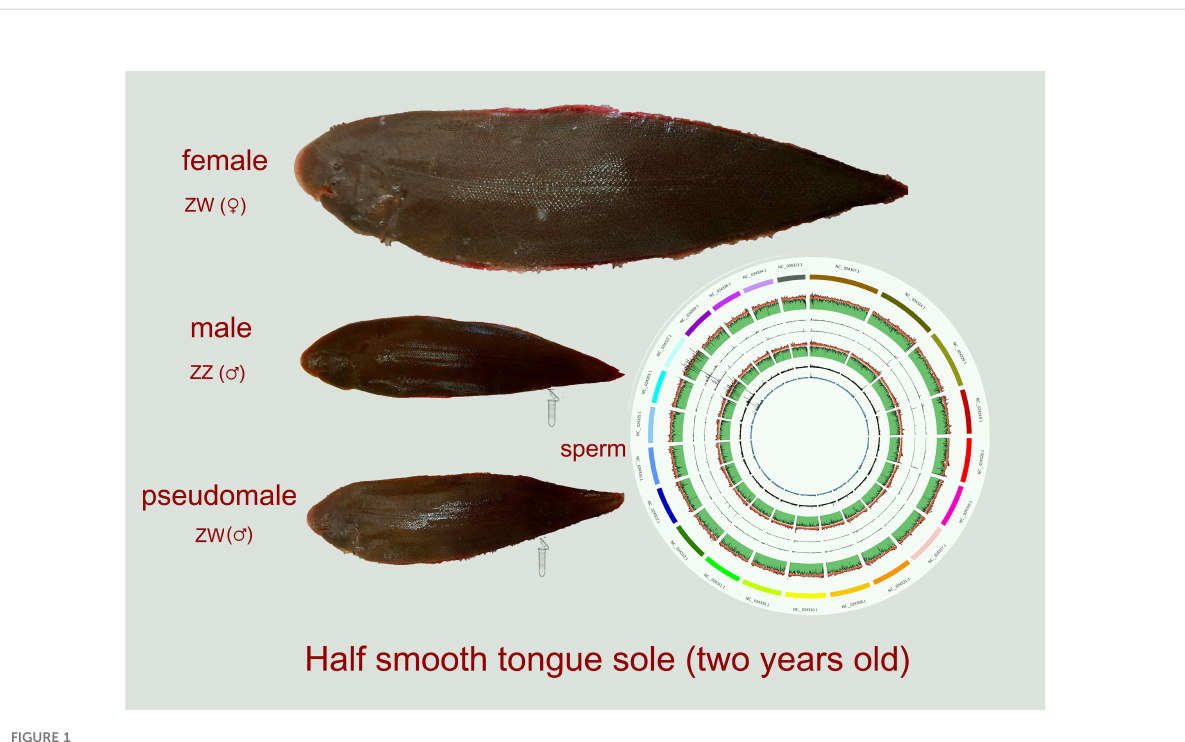
FIGURE 1 Schematic diagram of sex type grouping and sampling of Cynoglossus semilaevis. ZW ( ♀ ) represented females, ZZ ( ♂ ) represented normal males, and ZW ( ♂ ) represented pseudomales, all donors were about 2-